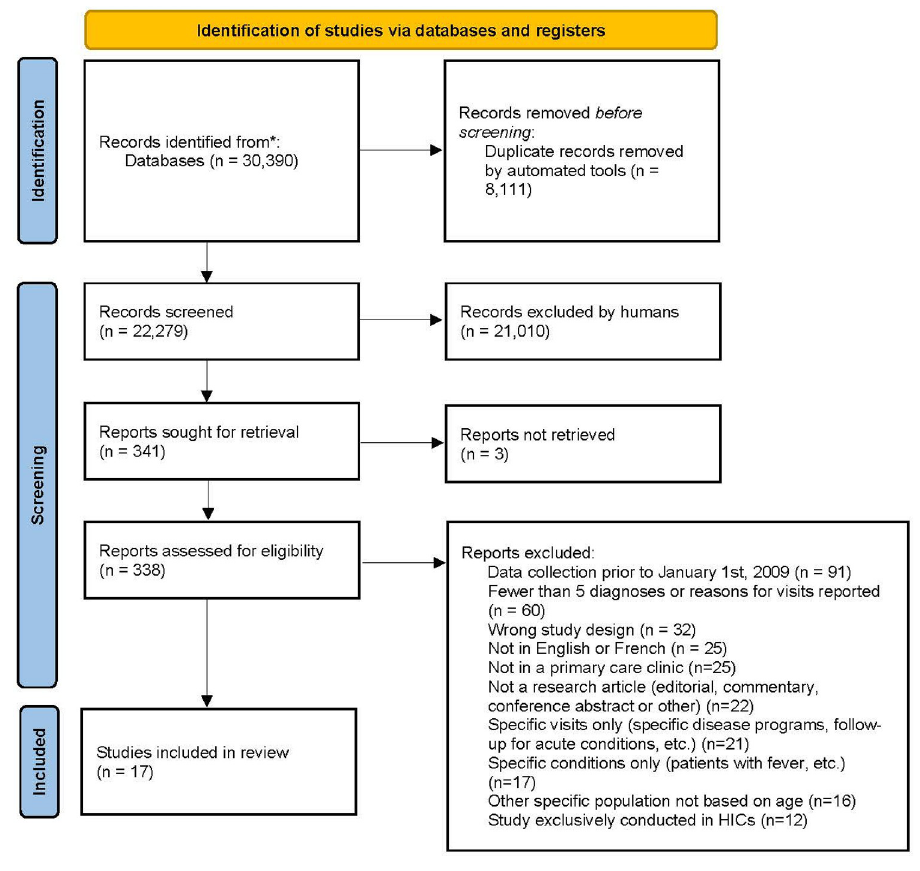
Fig 1. PRISMA flow